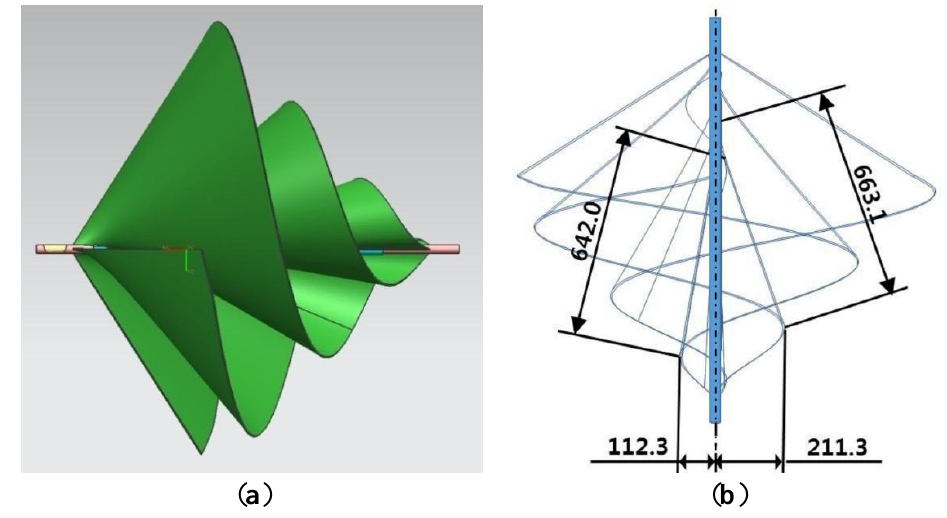
Figure 1. Schematic diagram of the Archimedes spiral wind turbine blade: ( a ) Side-view of the Archimedes spiral wind turbine blade; ( b ) Geometry of a 0.5 kW Archimedes wind turbine